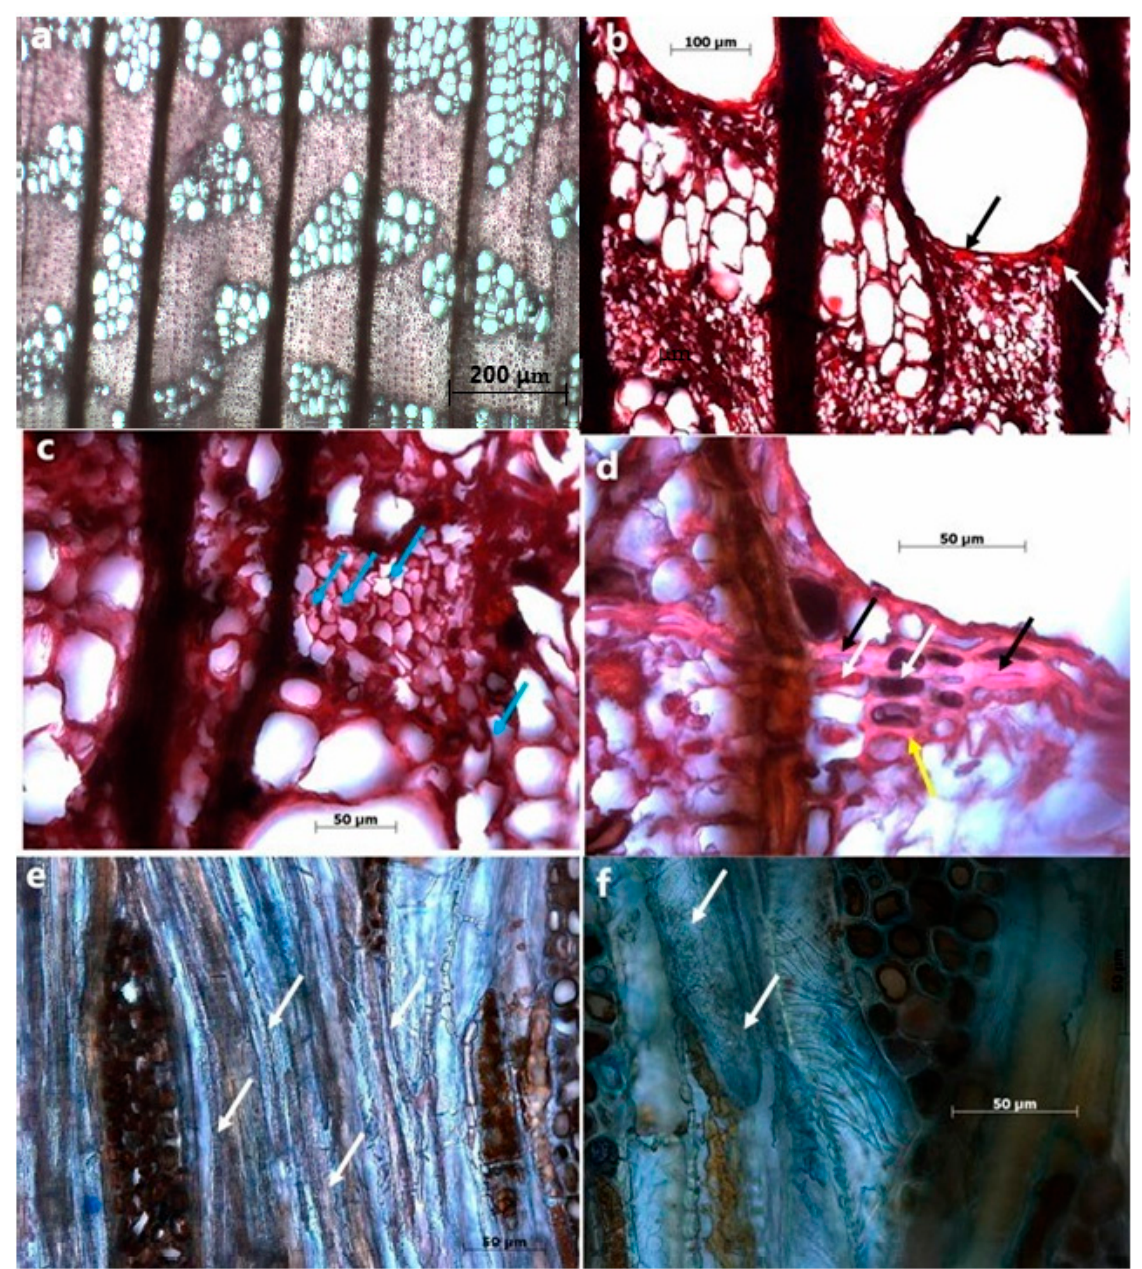
Figure 3. Light microscopy of cross-sections of recently cut ( a ) and archaeological elm ( b – d ) and from tangential section of archaeological elm using polarized light ( e , f ). Arrows indicate the damaged parts of archaeological wood samples.